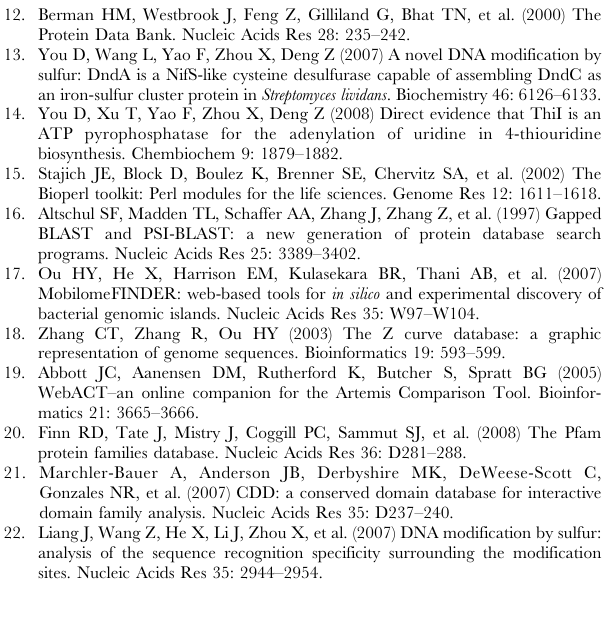
Figure 3. Organization of Dnd proteins and conserved domains in dnd DB. ( A ) DndA protein data that have been used to predict its putative biological function as a likely cysteine desulfur-transferase in Streptomyces lividans . ( B ) Multiple amino acid sequence alignment of DndA proteins highlighted the conserved domain in Pfam (accession no. PF00266). ( C ) and ( D ) Phylogenetic trees drawn on basis of DndA amino acid sequences and 16S rDNA sequences of the host organisms, respectively. ( E ) A 3-D structural image corresponding to a DndA-related protein (PDB ID: 1p3w). ( G ) Sample experimental data demonstrating that DndA provides sulphur via its L-cysteine desulfurylase activity [13]. ( F ) Inferred biochemical reaction, in which DndA is predicted to catalyze the assembly of DndC as an iron–sulfur cluster protein